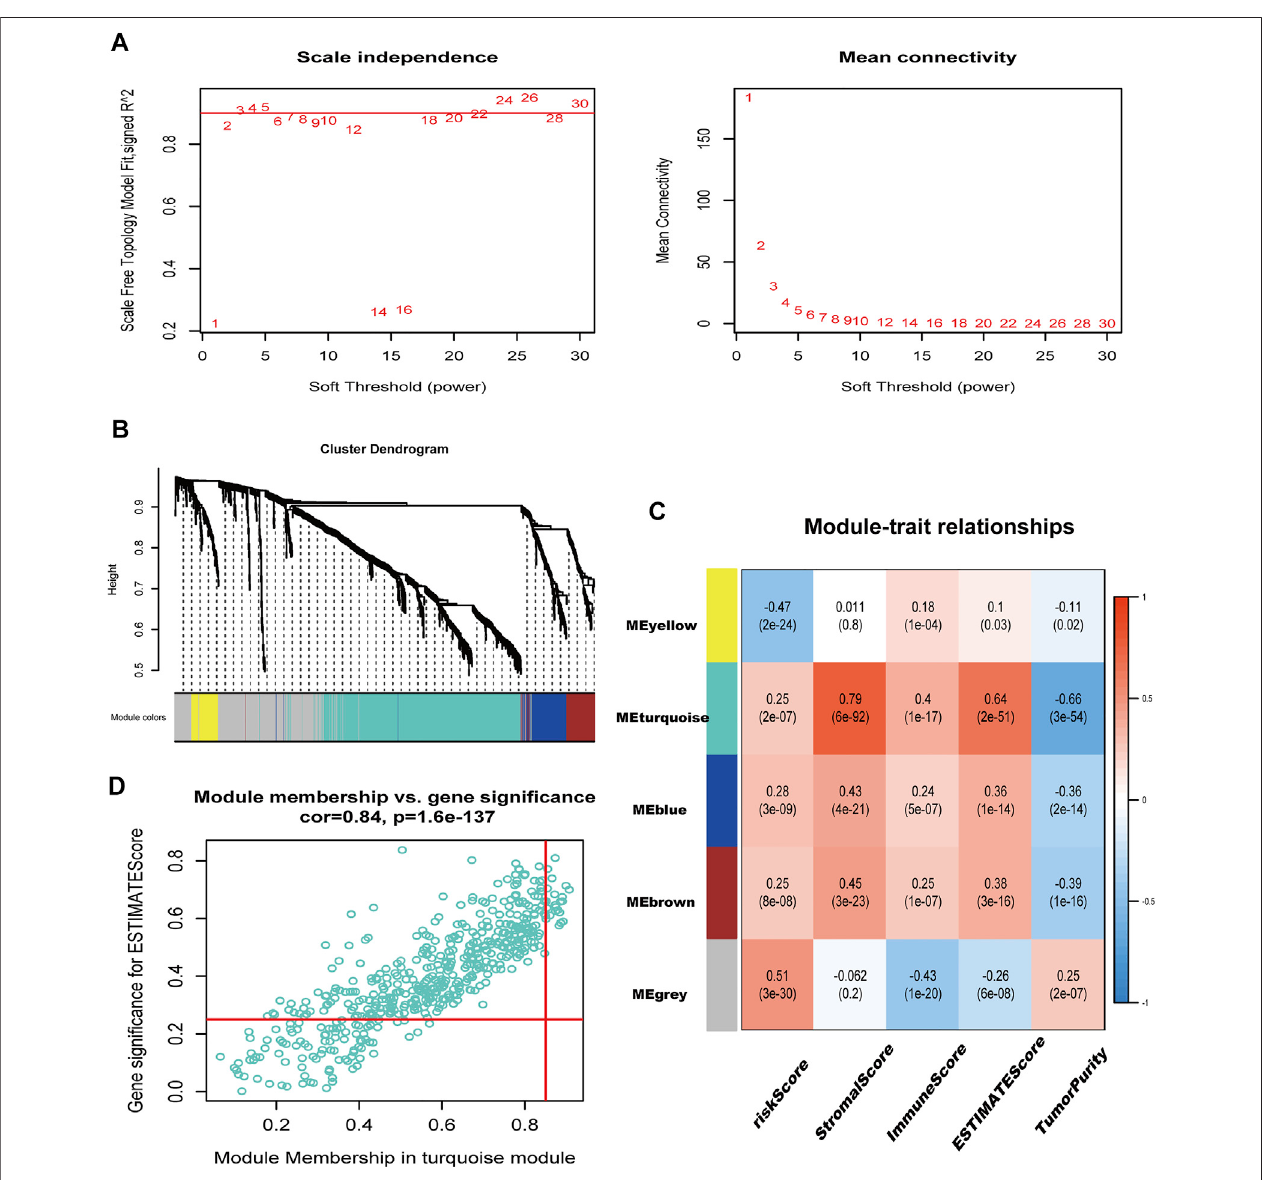
FIGURE 8 | immune-related genes were identi fi ed in WGCNA. (A) Filtering of soft power. (B) Diagram of fi ve modules with different colors. (C) Heatmap of the correlation between modules and immune-related scores. (D) Identi fi cation of genes with high GS and MM (GS > 0.25, MM > 0.85).